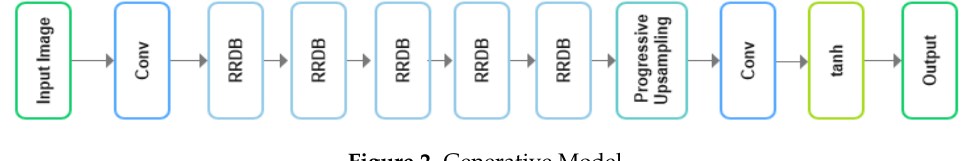
Figure 2. Generative Model.